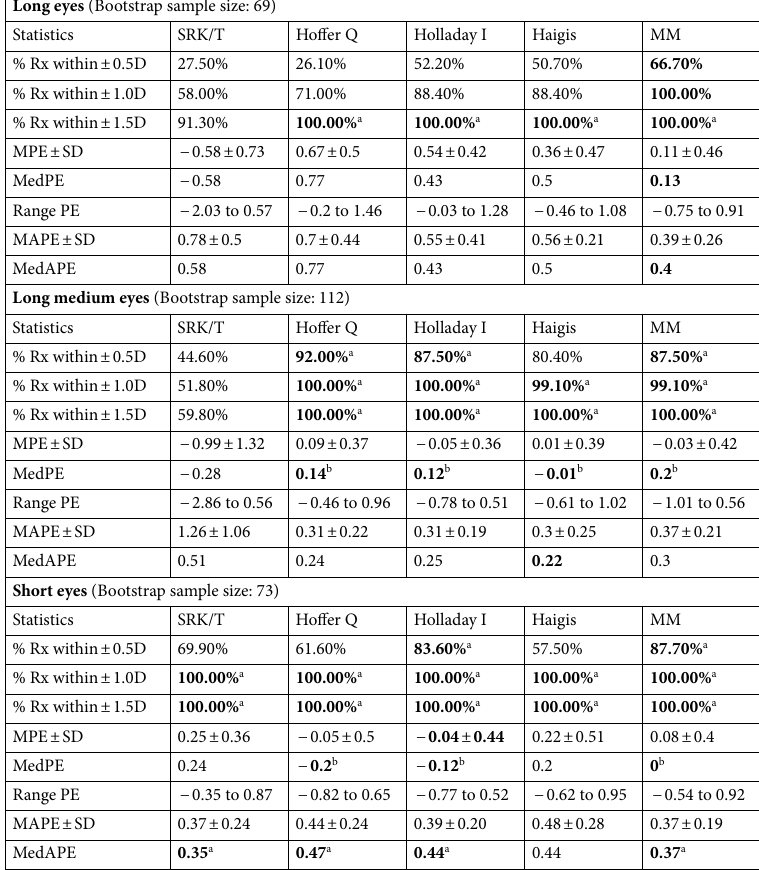
Table 8. Summary statistics of the cross-validation results for each of the five formulae (SRK/T, Hoffer Q, Holladay I, Haigis and MM) for long, long medium and short eyes. % Rx Percentage of eyes within a given range of prediction erro, MPE Mean prediction error, MedPE Median prediction error, Range PE Range of the prediction error, MAPE Mean absolute prediction error, MedAPE Median absolute prediction error, SD Standard Deviation of the error. a No statistically significant difference at level 0.05. b No statistically significant difference from zero at level 0.05. Significant values are in